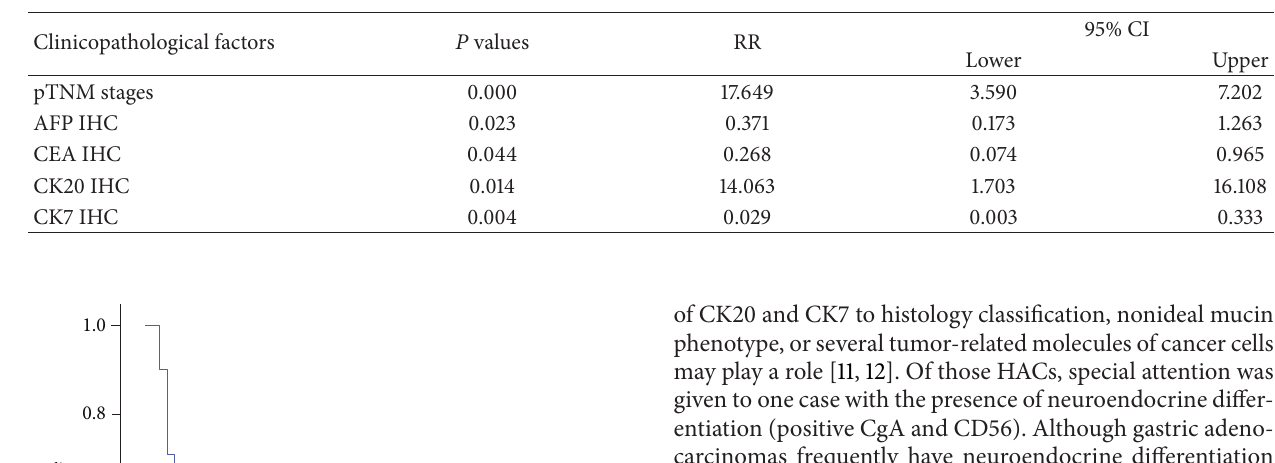
Table 2: Prognostic factors related to prognosis by Cox multivariate regression analysis.